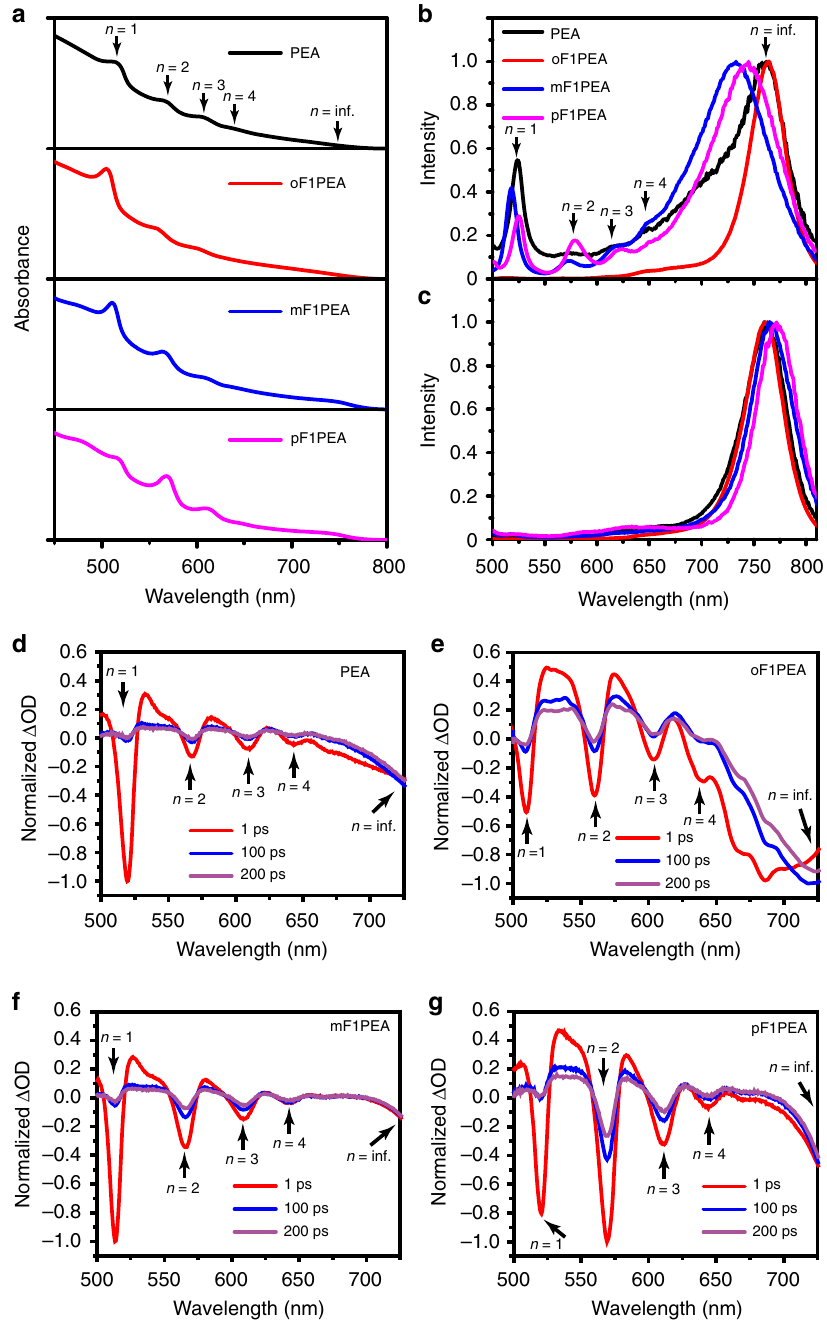
Fig. 2 Optical properties of 2D OIHP fi lms: a UV – Vis absorption; b normalized photoluminescence from back (glass) side, and c from front (air) side. Transient absorption spectrum excited from back (glass) side of 2D OIHP fi lms based on PEA ( d ), oF1PEA ( e ), mF1PEA ( f ), and pF1PEA ( g ). The excitation wavelength was chosen at the absorption peak of the particular n = 1 phase for each 2D OIHP fi lm, i.e., 517, 506, 510, and 518 nm, respectively. Numbers and arrows indicate signals from different inferior device performance (e.g., low V oc , FF). In contrast, both mF1PEA and pF1PEA 2D OIHP fi lms are uniform without pinholes, a surface morphology conducive to the high device performance we achieved. Probing the surface roughness with atomic force microscopy (AFM) also shows a similar trend (Supplementary Figure 10), with mF1PEA and pF1PEA fi lms show the smallest roughness (less than 20 nm). Overall, we observed the consistent relationship between the surface mor- phology and device performance.